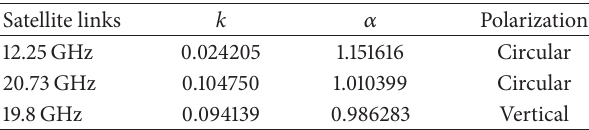
Table 1: Regression coefficients obtained from ITU-R P. 838-3 approach